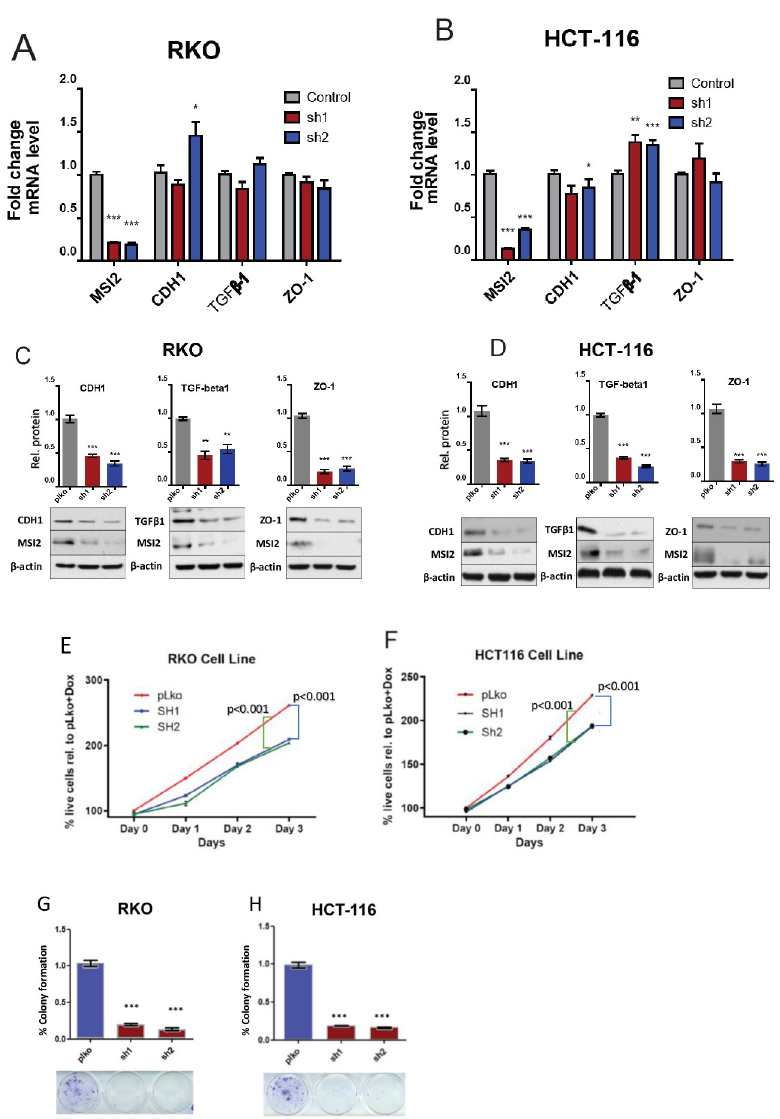
Fig 4. In vitro assessment of MSI2 depletion in CRC cell lines. (A-D) Averaged values for qRT-PCR ( A, B ) and Western blot ( C, D ) for MSI2, CDH1, TGF β 1, and ZO1 in control and MSI2-depleted RKO and HCT116 cell lines. ( E-H ) Cell viability ( E, F ) and clonogenic capacity ( G, H ) of control or MSI2-depleted RKO and HCT116 CRC cell lines. � , p < 0.05; �� , p < 0.01; ��� , p < 0.001, in each case in reference to control-depleted cells; non-significant comparisons are not